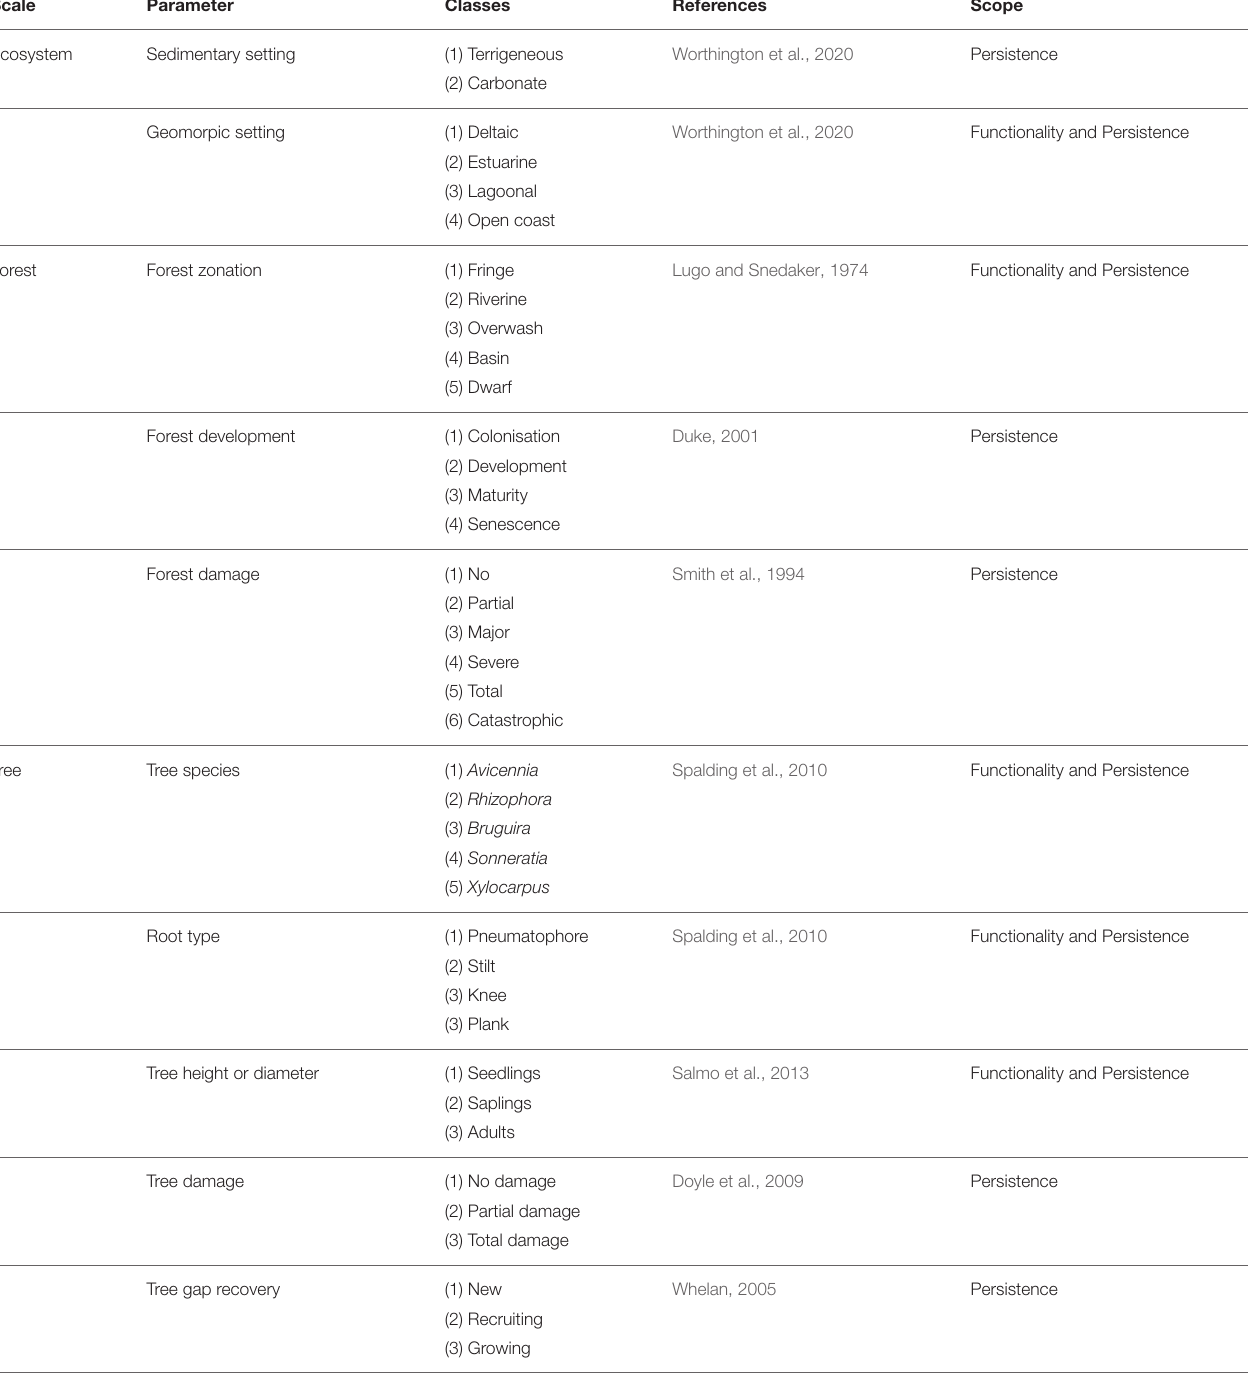
TABLE 1 | Existing classification models for the categorization of mangroves in flood risk management.